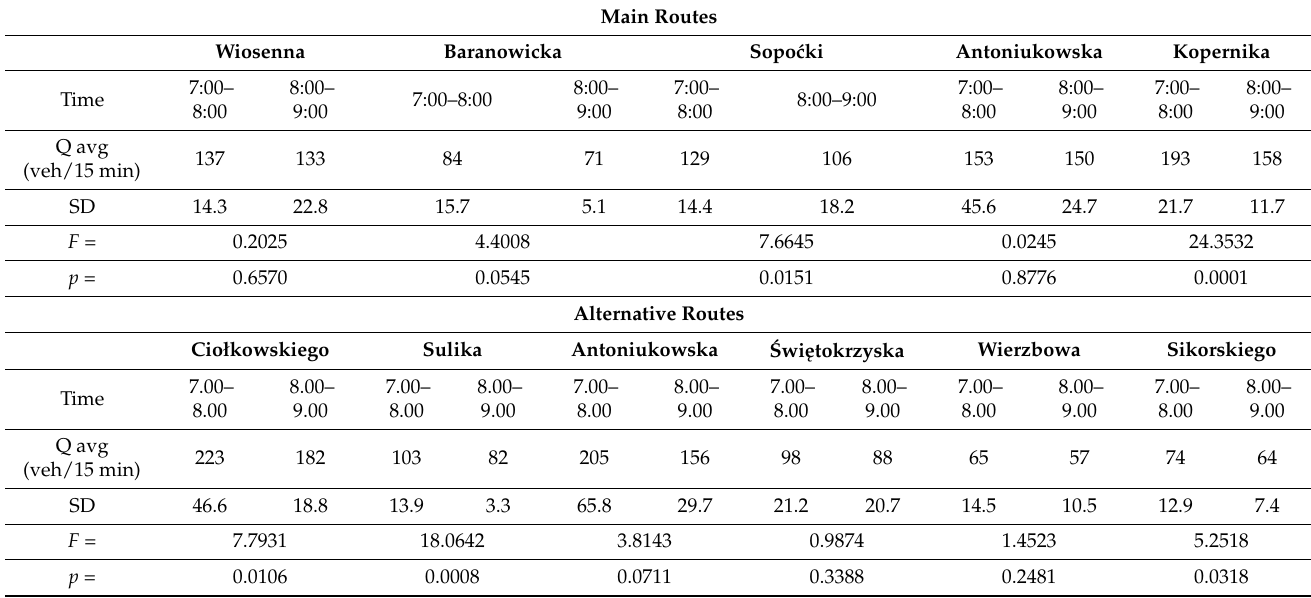
Table 3. ANOVA results for main and alternative routes.